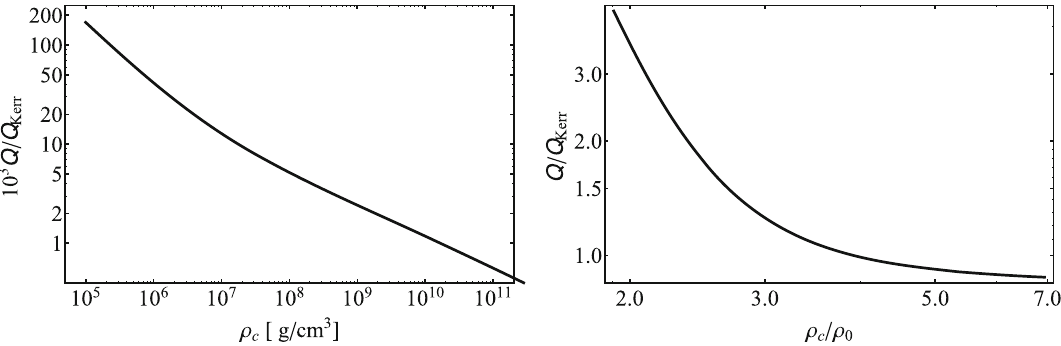
Fig. 2 The mass quadrupole moment Q over the Kerr quadrupole moment Q Kerr = J 2 /( c 2 M ) versus central density ρ c . Left panel: maximally rotating WDs. Right panel: maximally rotating NSs, where ρ 0 is the nuclear